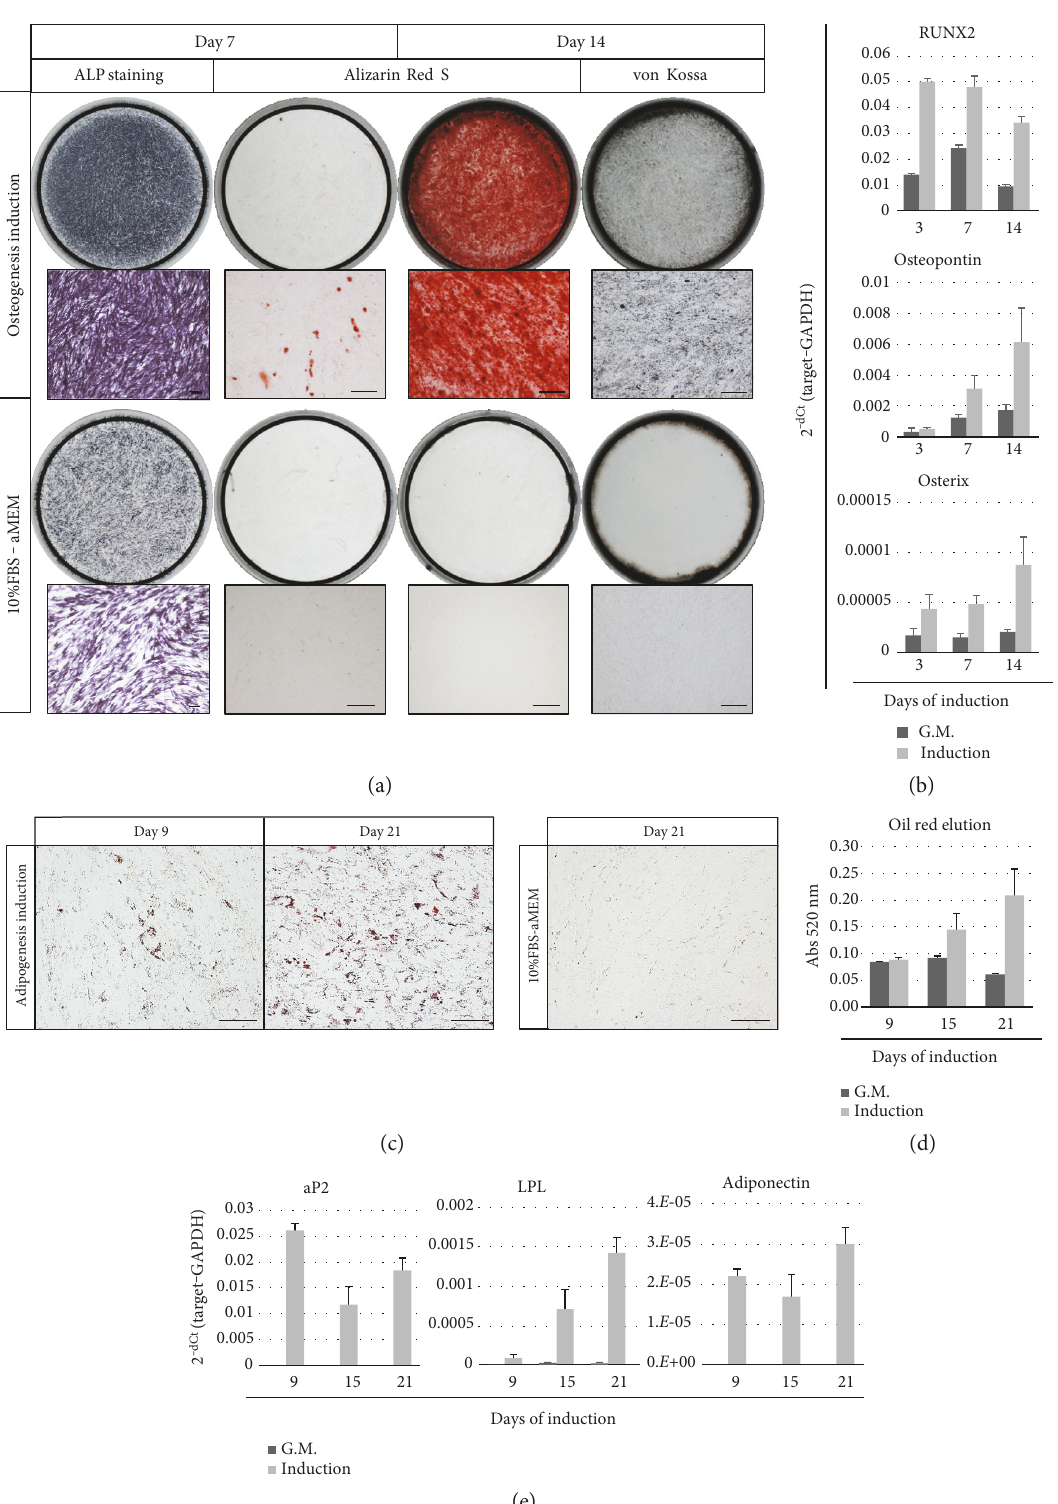
Figure 5: Osteo- and adipogenesis of iNCMSCs. The representative data for three lines is shown. (a) ALP staining at day 7 and calcium staining (alizarin red S and von Kossa staining) at day 14 of iNCMSCs cultured in osteogenic medium in 24-well plates. (b) Osteogenesis- related gene expression at days 3, 7, and 14. (c) Oil red staining of iNCMSCs cultured in adipogenesis medium at days 9 and 21. (d) Measurement of oil red positive droplets. (e) Adipogenesis-related gene expression at day 9, 15, and 21. Data are expressed as mean ± SD for three well replicates per group (b, d, e). Scale bars =100 μ m (a, c). Abbreviations: ALP: alkaline phosphatase; G.M.: growth